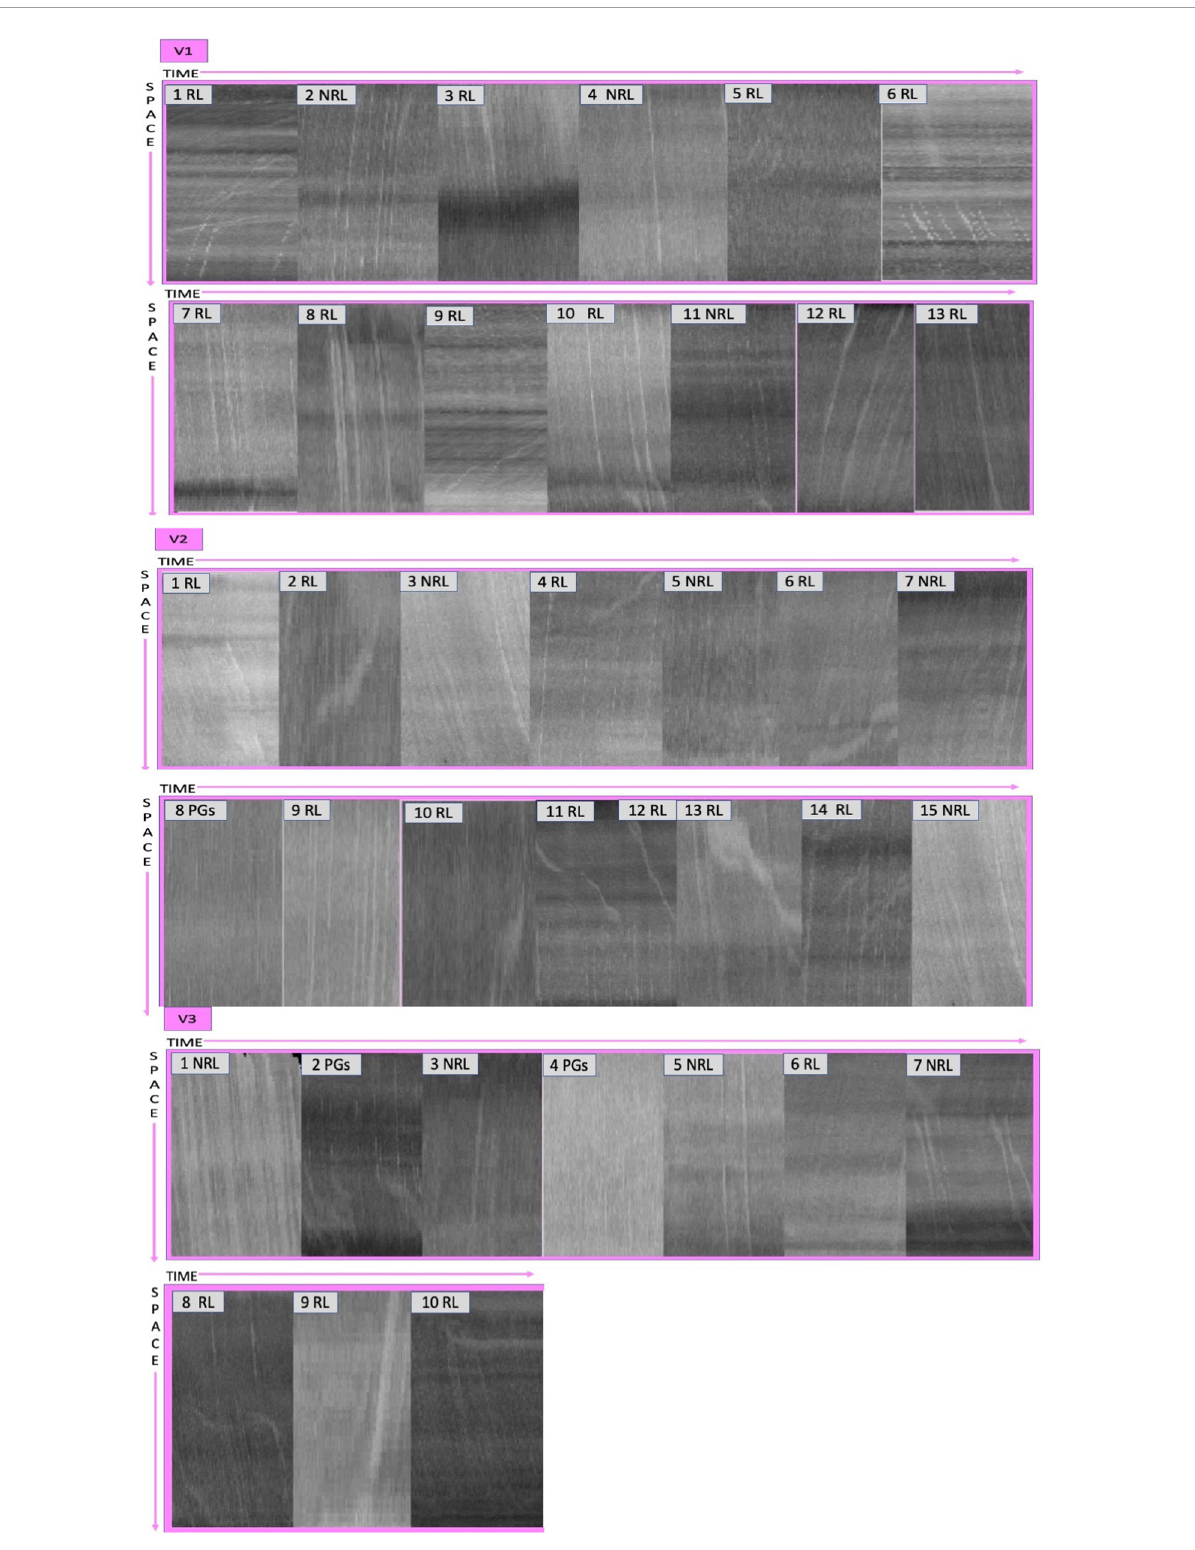
FIGURE3 Space time diagrams describing the behavior of the leukocytes in PCV-units. RL, rolling leukocytes; NRL, no-rolling leukocytes; PGs, plasma gaps.